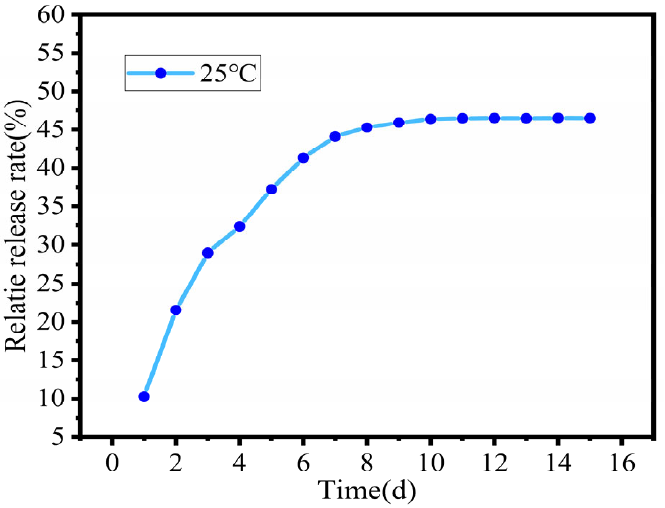
Figure 7. Sustained-release performance of SPEO-Ms.